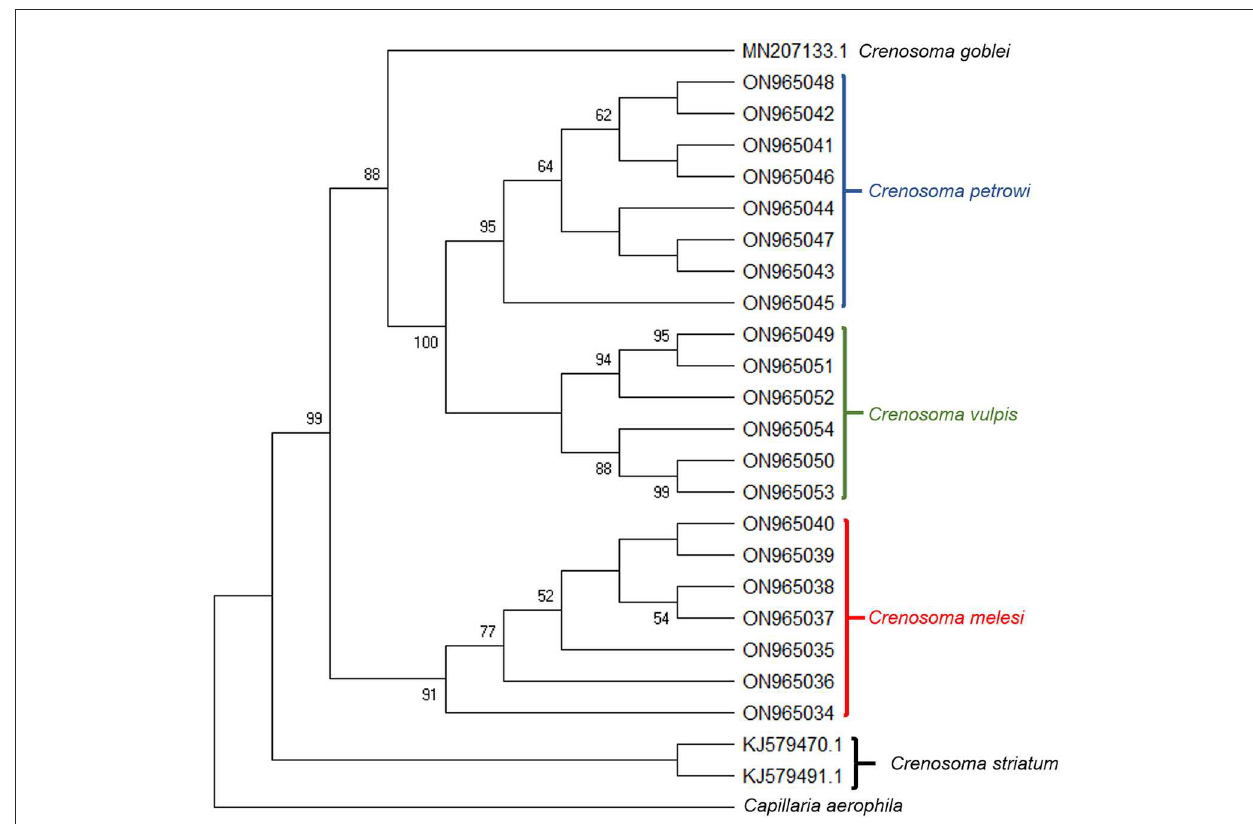
FIGURE5 Bootstrap consensus tree inferred from 1000 replicates, taken to represent the evolutionary history of the taxa analyzed. The percentage of replicate trees in which the associated taxa clustered together in the bootstrap test (1,000 replicates) are shown next to the branches. The analysis involved 24 Crenosoma cox 1 nucleotide sequences obtained during the present study (21) or retrieved from the GenBank database (3), and one sequence of Capillaria aerophila , used as outgroup.